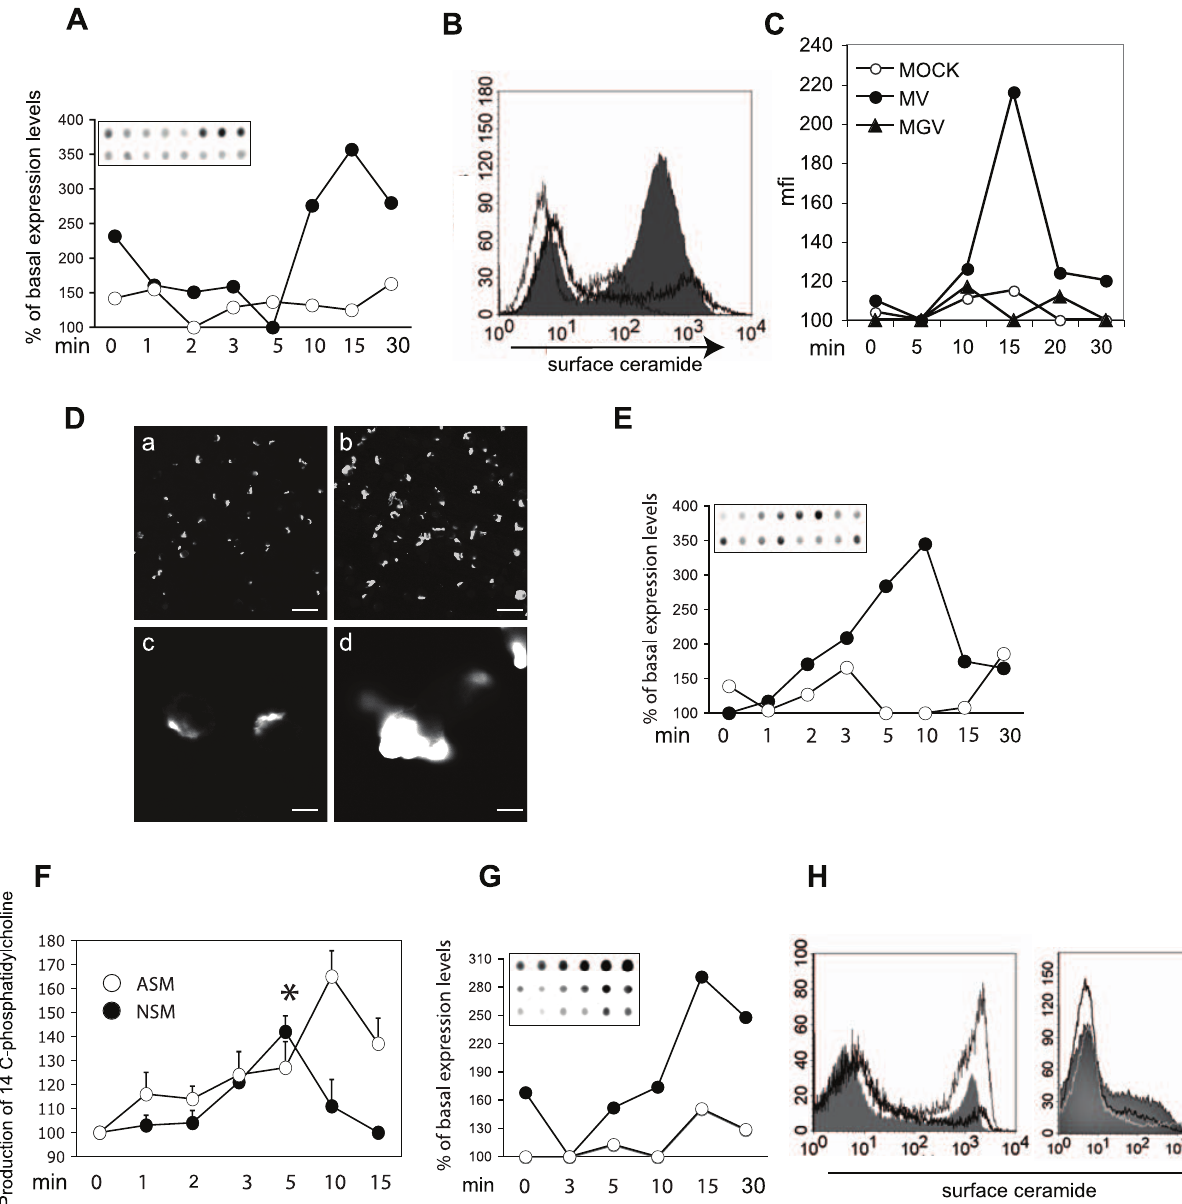
Figure 1. MV causes SMase activation and membrane ceramide accumulation in human T cells. (A–D) Extracellular oriented ceramide accumulation was detected on Jurkat T cells exposed to MV (black symbols) or a MOCK preparation (white symbols) after the time intervals indicated. (A) By spot assay. Levels indicated were normalised to those measured on untreated cells; one out of three independent experiments is shown (inset: MV: upper, MOCK bottom row). (B–D) By surface detection. (B,C) FACScan on cells exposed to (B) MOCK (solid black curve) or MV (filled histogram) (exemplified for a 10 min exposure) (the grey line indicates staining of the isotype control antibody) or (C) MOCK, MGV (black triangles) or MV for the time intervals indicated (min), (D) by immunofluorescent staining (exemplified for a 10 min exposure to MOCK (a and blow up in c) or MV (b and blow up in d) (bars represent 25 (a, b) or 5 m m (c, d)). (E) Surface display of ASM was determined on Jurkat T cells exposed to MOCK (white symbols) or MV (black symbols) for the time intervals indicated by spot assay (inset; MV upper, MOCK bottom row (as in (A), values were normalised to those measured on untreated cells)). (F) ASM (open symbols) and NSM (closed symbols) activation by MV was measured by conversion of 14 C- sphingomyelin to 14 C-phosphorylcholine by extracts prepared from MV or MOCK-treated cells within 1 hr. Values shown indicate production of 14 C- phosphorylcholine by MV over time, each expressed in relation to the respective MOCK control; levels of NSM activation significantly exceeding the background (t-test, p=0.01) are indicated by an asterisk (data were generated in three independent experiments, standard deviations are indicated). (G) ASM surface display on primary human T cells in response to MOCK (white symbols) or MV (black symbols) over time measured by spot assay (inset; MV middle, MOCK bottom row). CD28-activation was used as a positive control (inset, upper row). (H) Left panel: Primary human T cells were left untreated (grey curve) or pre-exposed to amitriptyline (filled histogram) or GW4869 (black curve) for 2 hrs prior to MV exposure for the time intervals indicated, stained for ceramide surface display and analysed by FACScan. Right panel: Primary T cells were transfected using a scrambled (filled histogram) or a NSM2-specific siRNA (black and white line) prior to exposure to MOCK (white line) or MV (filled histogram and black line).